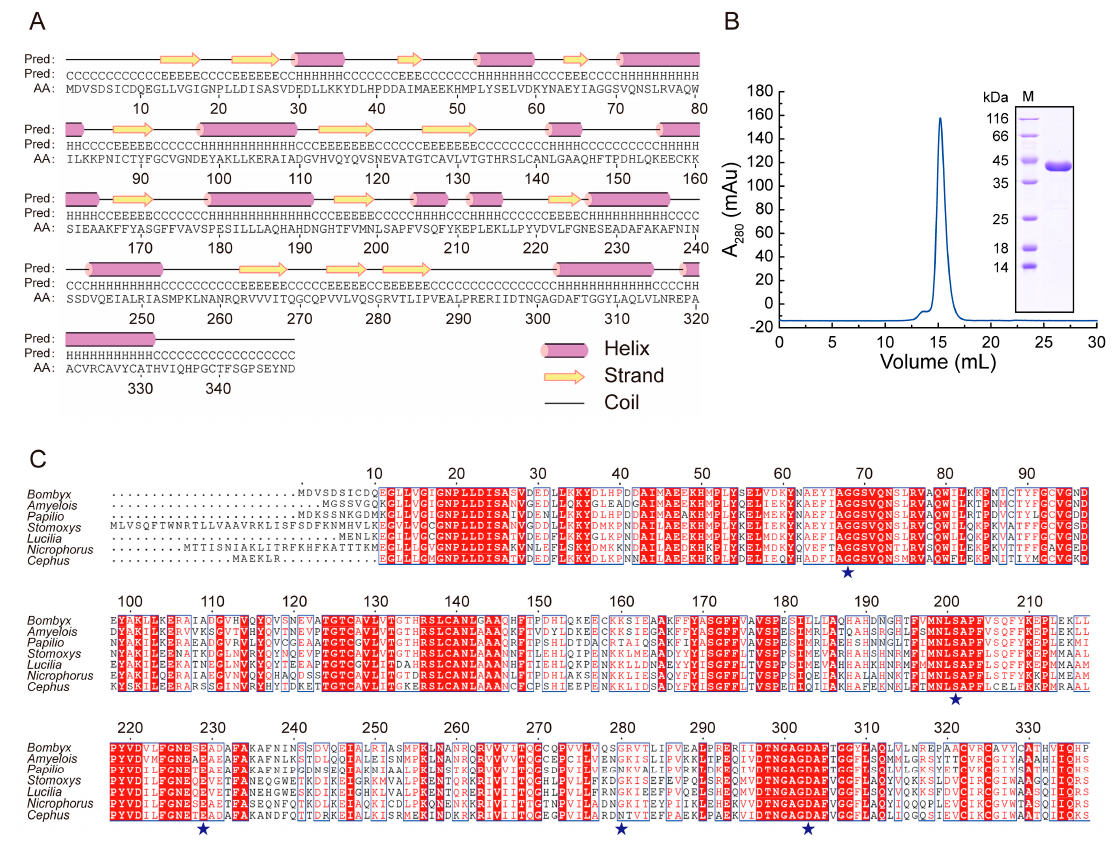
Figure 1. Structural prediction, purification of heterologously expressed Bombyx mori adenosine kinase (BmADK), and sequence comparison of ADK from different species. ( A ) Diagram shows the predicted secondary structure of BmADK. ( B ) Purification of BmADK by gel filtration and SDS-PAGE analysis. ( C ) Multiple sequence alignments of ADKs from Bombyx mori , Amyelois transitella , Papilio troilus , Stomoxys calcitrans , Lucilia cuprina , Nicrophorus orbicollis , and Cephus cinctus . Similarities are highlighted in red and mutation sites are marked with blue stars.